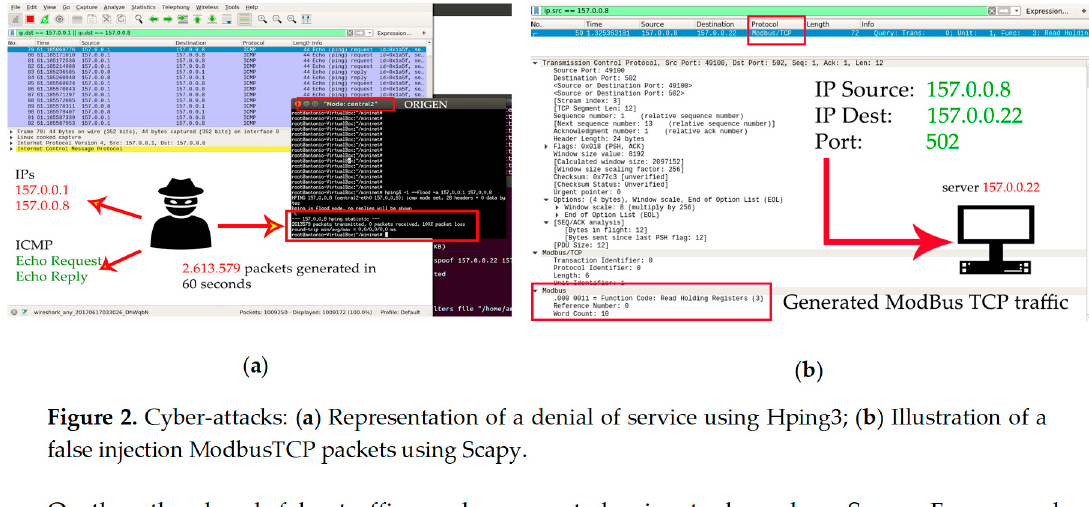
Figure 2. Cyber-attacks: ( a ) Representation of a denial of service using Hping3; ( b ) Illustration of a false injection ModbusTCP packets using Scapy.